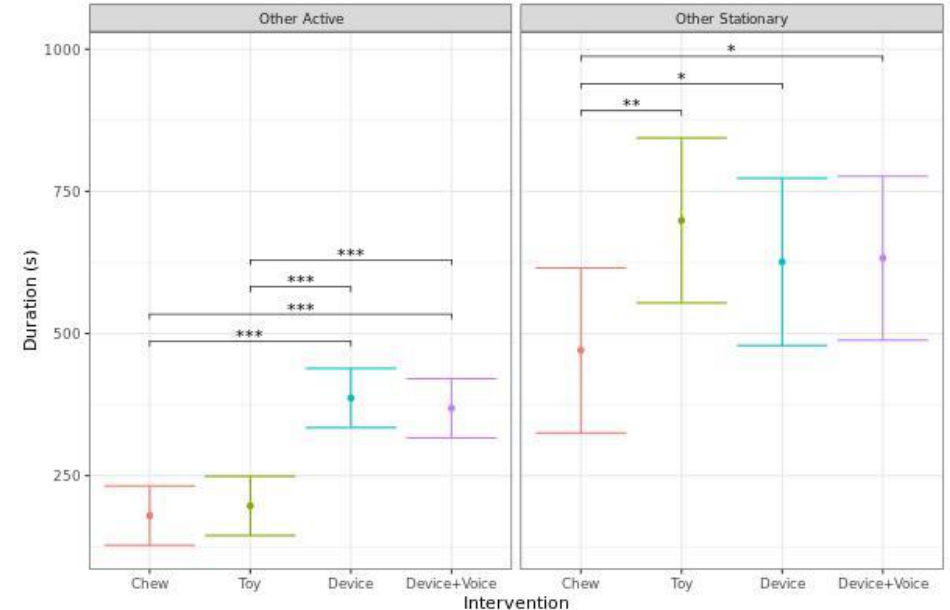
Figure 3. Predicted mean (95% CI) duration of time (s) spent performing other active behaviors, or other stationary behaviors when dogs were left alone with one of four enrichments for 20 min. Asterisks indicate significant differences between treatment groups. Three asterisks indicate significance at p < 0.001, two asterisks indicate significance at p < 0.01, and one asterisk indicates significance at p < 0.05. There were no significant differences in the probability of escape or destructive be- havior based on intervention (Figure 4).